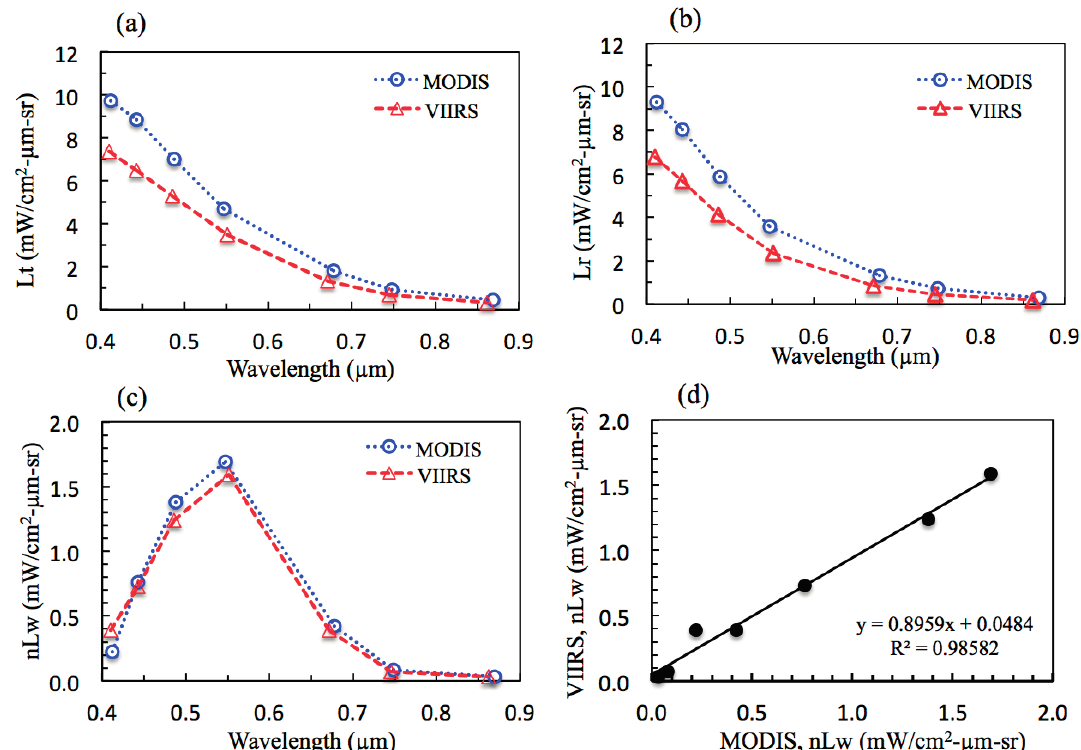
Figure 10. ( a ) Top-of-Atmosphere multi-channel radiances (Lt) of MODIS and VIIRS over Region 1; ( b ) APS-calculated Rayleigh path radiances (Lr) of MODIS and VIIRS; ( c ) Spectra of normalized water-leaving radiances (nLw) of MODIS and VIIRS retrieved with APS; and ( d ) scatter plot of VIIRS versus MODIS nLw estimates.